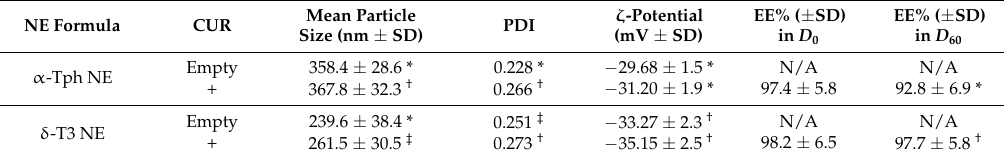
Table 1. Physico-chemical properties and stability of developed CUR-NE preparations ( n = 3–4, mean values denoted with unlike symbols are statistically different, p ≤ 0.05).